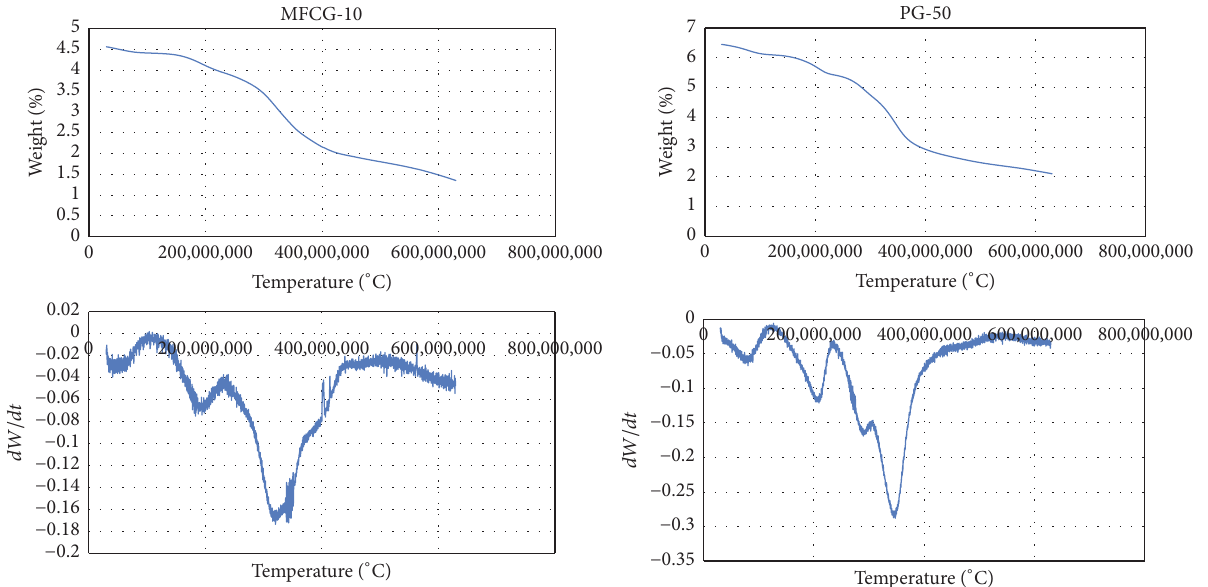
Figure 13: TGA/DTG curves of MFCG-10 and